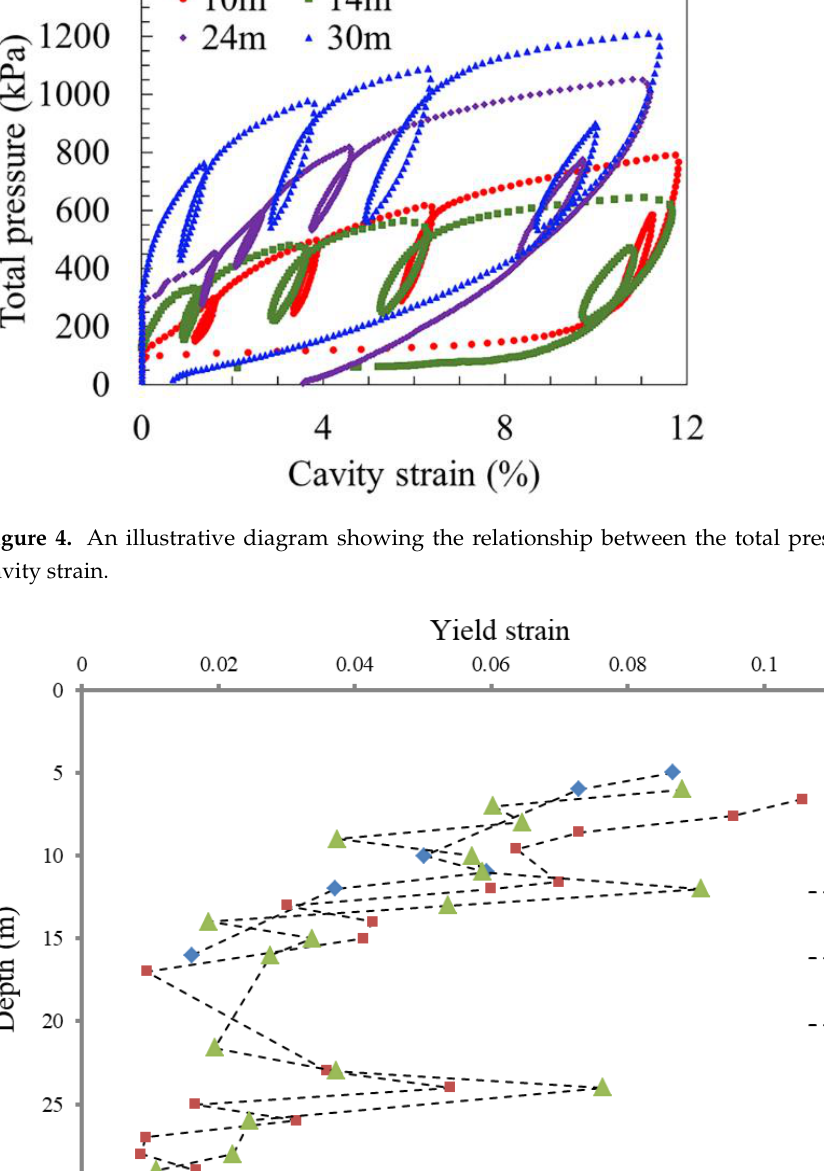
Figure 4. An illustrative diagram showing the relationship between the total pressure and the cavity strain.